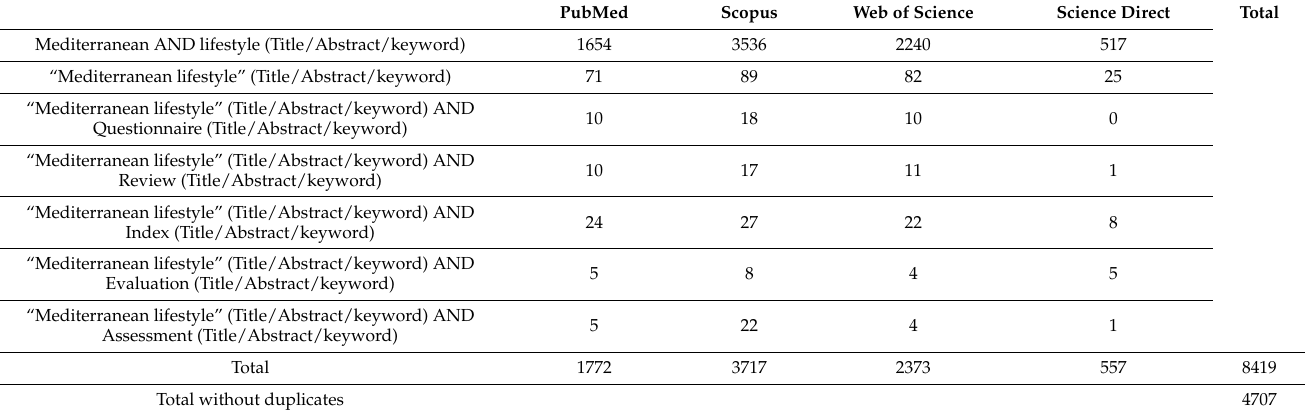
Table 2. Bibliographic search